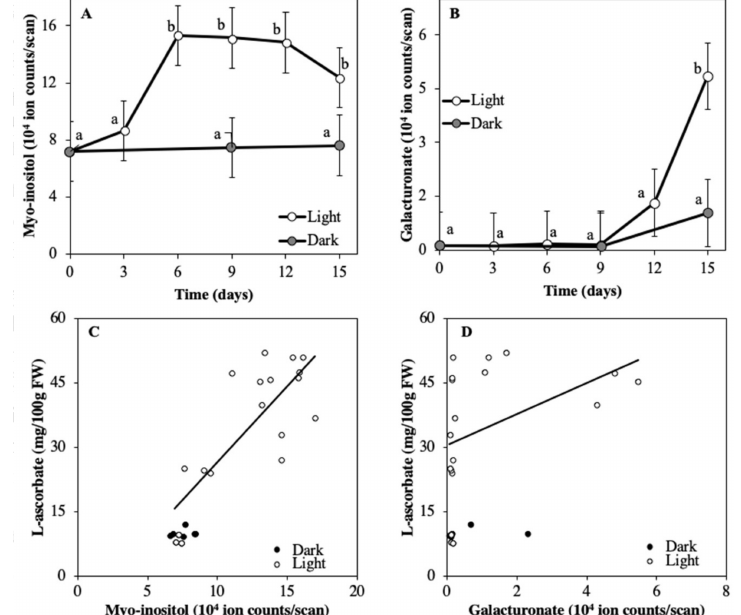
Figure 2. Relative level of ASC precursors myo-inositol ( A ) and galacturonate ( B ) in detached mature green tomato fruits stored in 500 µ mol m − 2 s − 1 light (open symbols) and darkness (closed symbols) for 15 days. C and D show the relation between ASC and ASC precursors (myo-inositol and galacturonate, respectively) for the light and darkness treatments. Each data point is based on pooled sample of pericarp discs of 2 fruits. Solid lines in C and D represent a linear fitting on data points of the light treatment. Error bars represent standard errors of means, letters indicate statistical difference at α = 0.01; n = 5; Experiment